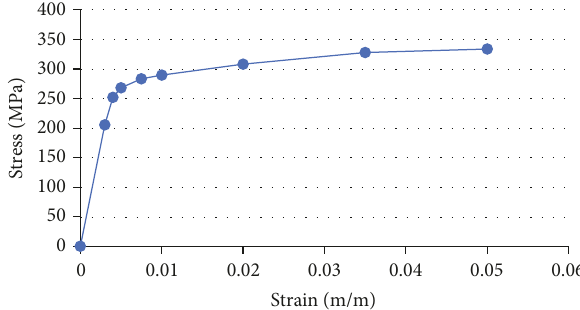
actual cutouts were made to gather imperfection data related to manufacturing imperfection signatures.